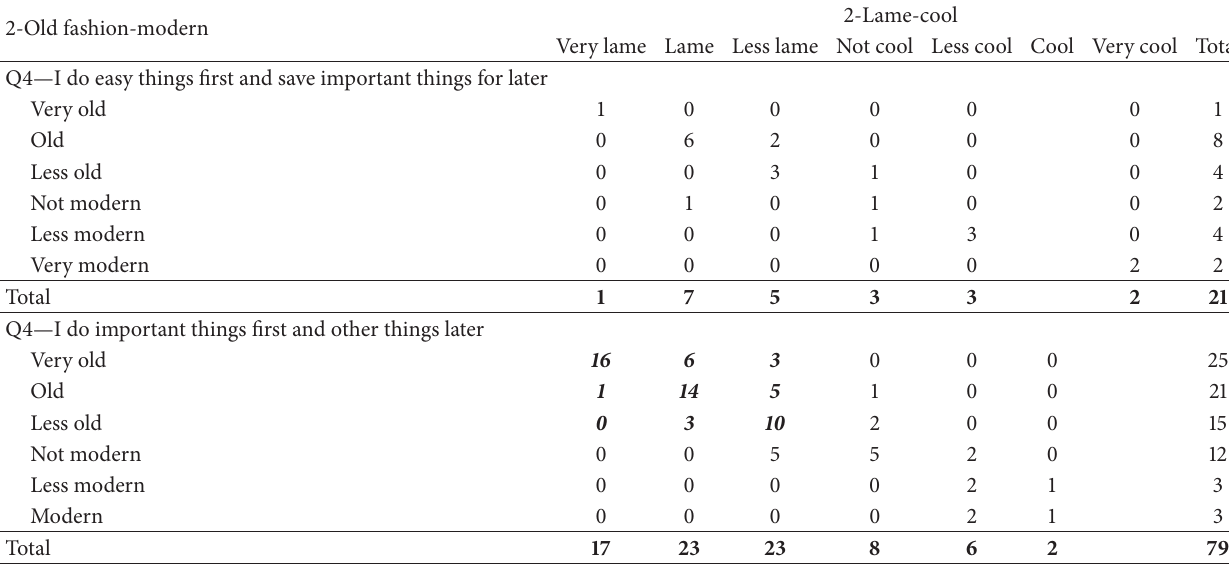
Table 12: Correlation between Design no.2 toward Kansei Words